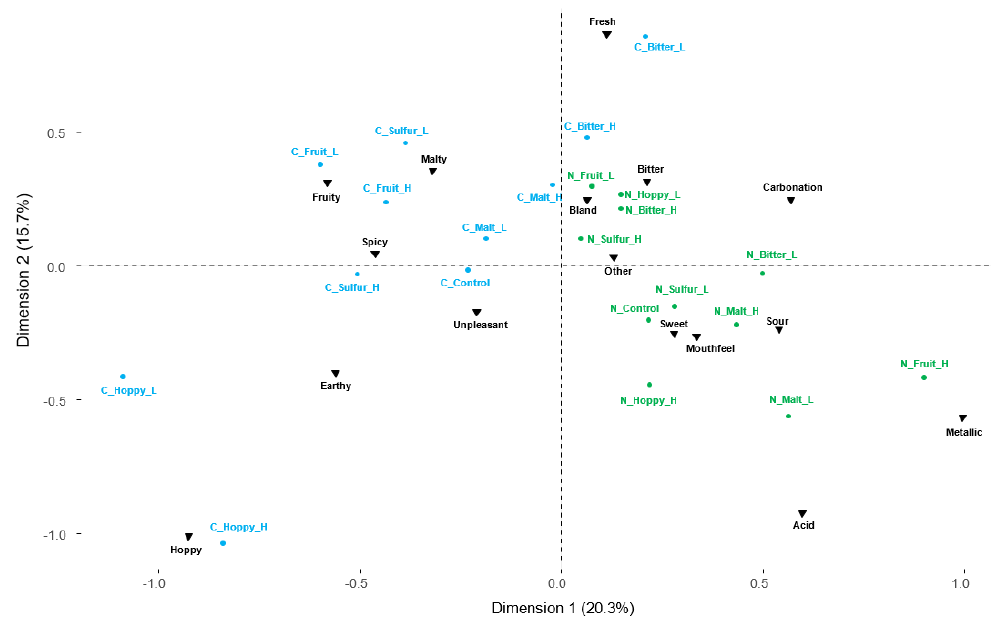
Figure 2. Correspondence analysis from identification test without an attribute list. Answers are grouped into themes (black triangles). The craft-style group answers are colored in blue. Non-drinkers are colored in green.